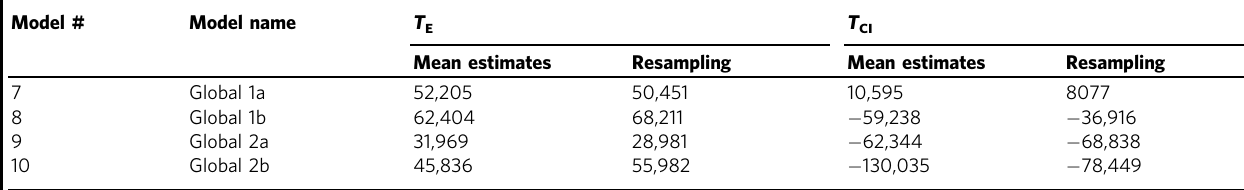
Table 3 Predicted extinction dates for the Acheulean cultural tradition at a global level.